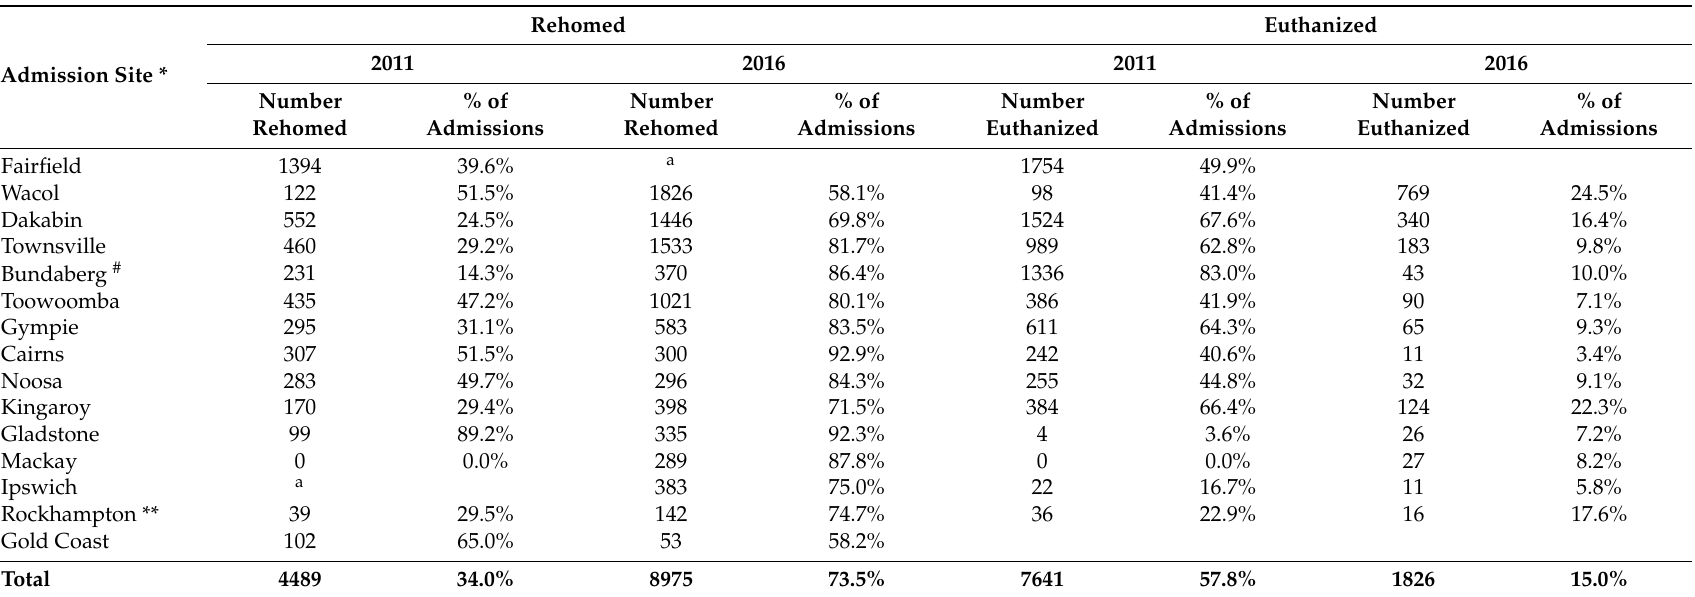
Table A3. Summary of cat outcomes of ‘rehomed’ and ‘euthanized’ by admission site (RSPCA shelter or adoption center) for 2011 and 2016 for cats whose outcome was resolved by the 90th day (‘day 90’; where day 1 was the day the cat was admitted), excluding movements to pet supply stores and RSPCA adoption events in 2011 and 2016. Note: These results differ slightly from those reported on the RSPCA national website [3] because of differences in inclusion and exclusion criteria, and analysis by calendar year rather than final year. For cats moved between RSPCA sites after admission, the outcome occurred at that subsequent site, but it is shown as an outcome for the admission